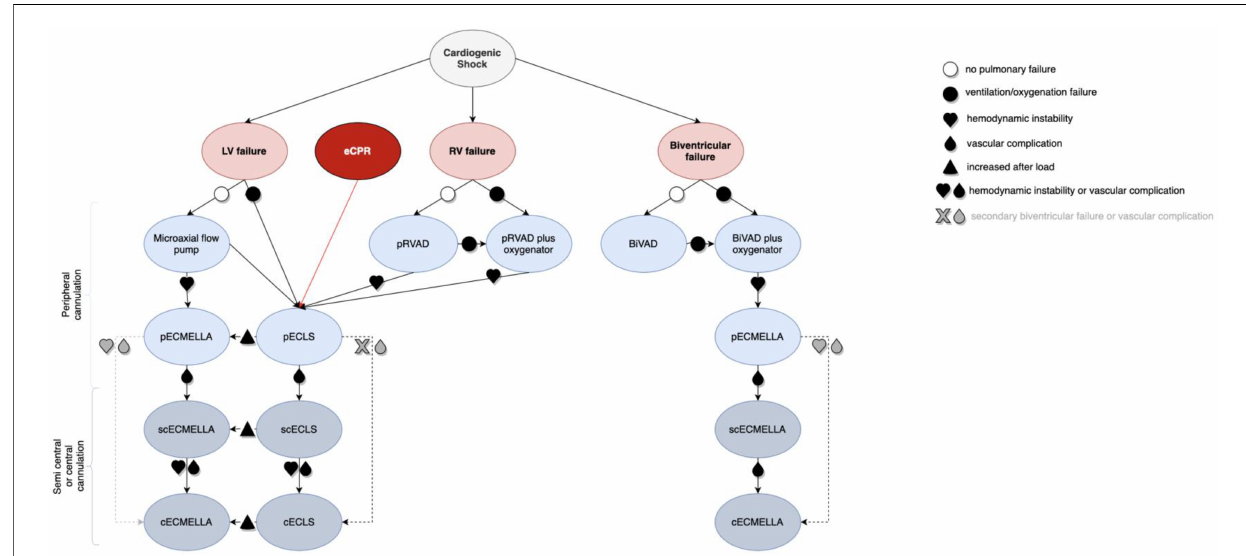
FIGURE 3 Decision algorithm for cannulation strategies in critical cardiogenic shock with the need for ECLS (visual take-home graphic). cECLS, central venoarterial extracorporeal life support; cECMELLA, central ECLS plus percutaneous microaxial pump; ECLS, extracorporeal life support; BiVAD, temporary percutaneous selective biventricular assist device; pECLS, peripheral venoarterial extracorporeal life support; pECMELLA, peripheral ECLS plus percutaneous microaxial pump; pRVAD, temporary percutaneous right ventricular support; scECLS, semicentral venoarterial extracorporeal life support; scECMELLA, semicentral ECLS plus percutaneous microaxial